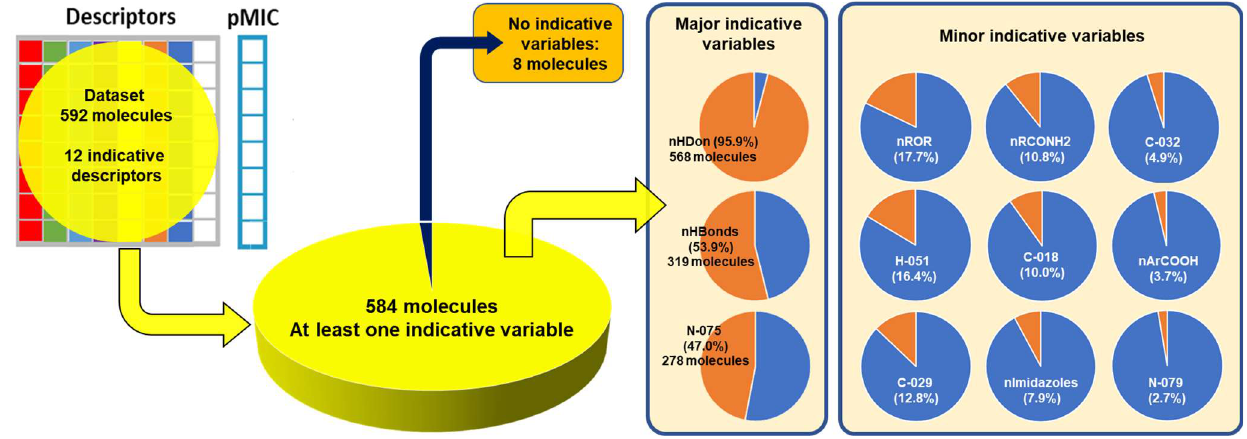
Figure 12. Local distribution of descriptors in molecules used in the model.